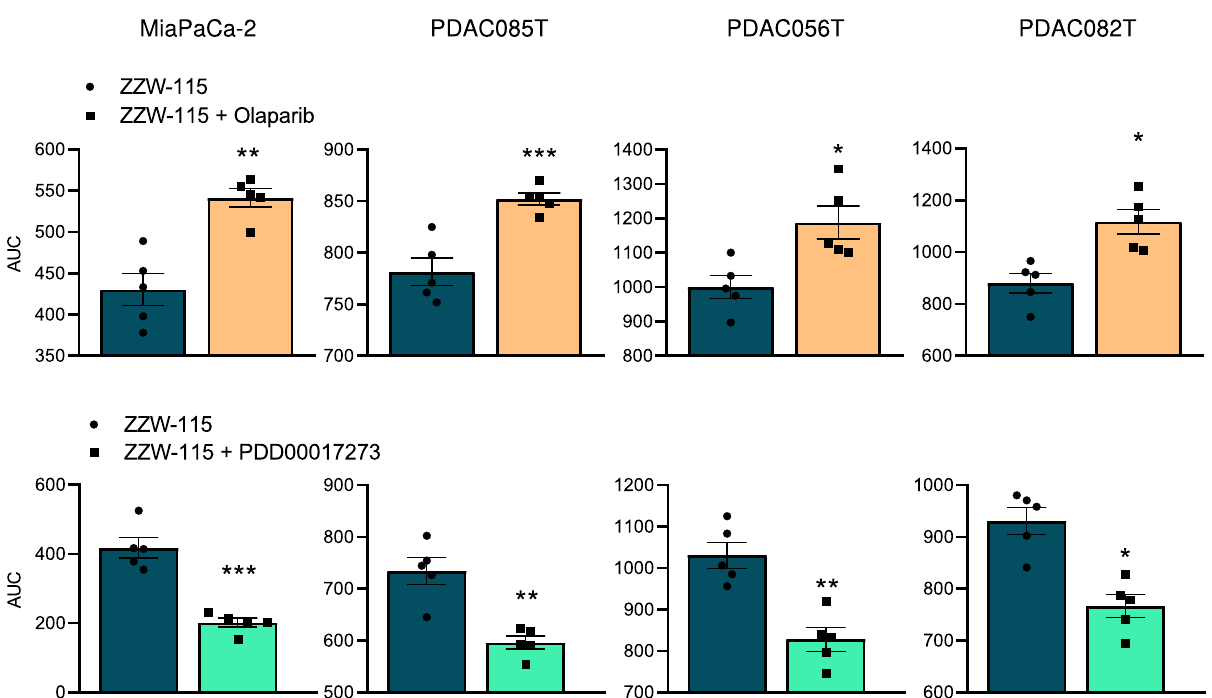
Fig. 3 NUPR1 inhibition-induced cell death was rescued by PARP1 inhibitor and enhanced by PARG inhibitor. Chemogram assays were done on 4 pancreatic cancer cell lines (MiaPaCa-2, PDAC085T, PDAC056T, and PDAC082T) with increasing concentrations of ZZW-115 in the presence or absence of olaparib (25 μ M) or PDD00017273 (1 μ M) for 24 h ( n = 5). Curves were plot in GraphPad software and the area under the viability curve (AUC) was calculated by integration. Data represent mean ± SEM. Student ’ s 2-tailed unpaired t test were used, * P < 0.05; ** P < 0.01; *** P < 0.001; **** P <